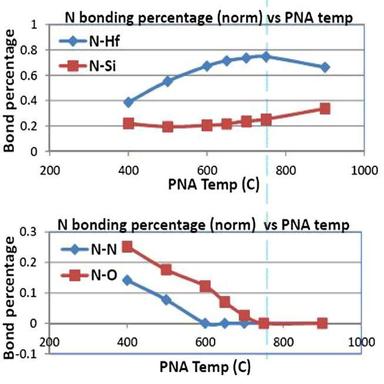
Different bonding percentage of 3a. N-Hf, N-Si and 3b. N-N and N-O at different PNA temperatures (IL is Chem-Ox SiO2).